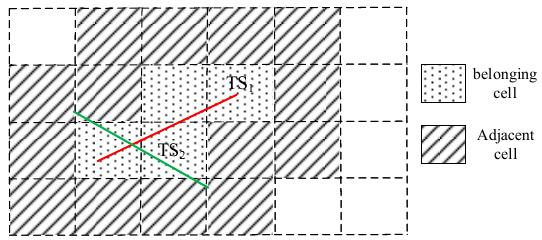
Figure 5. Schematic diagram of the belonged Cell and adjacent Cell.